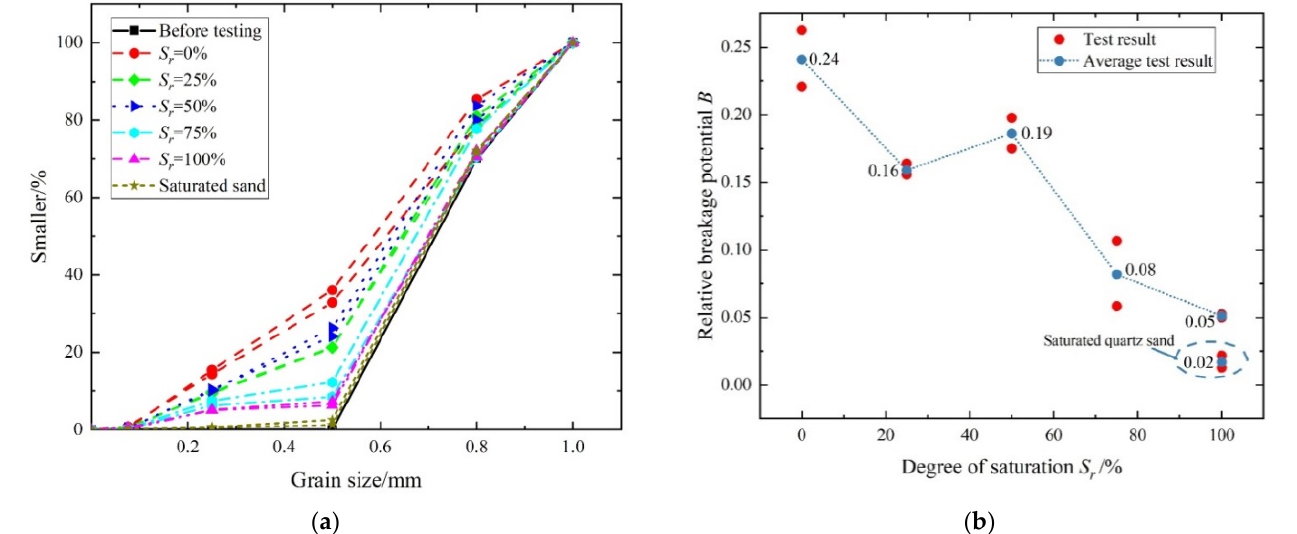
Figure 8. ( a ) Particle size distribution curves of specimens with different saturations after impact. ( b ) Variation diagram of average relative breakage potential.